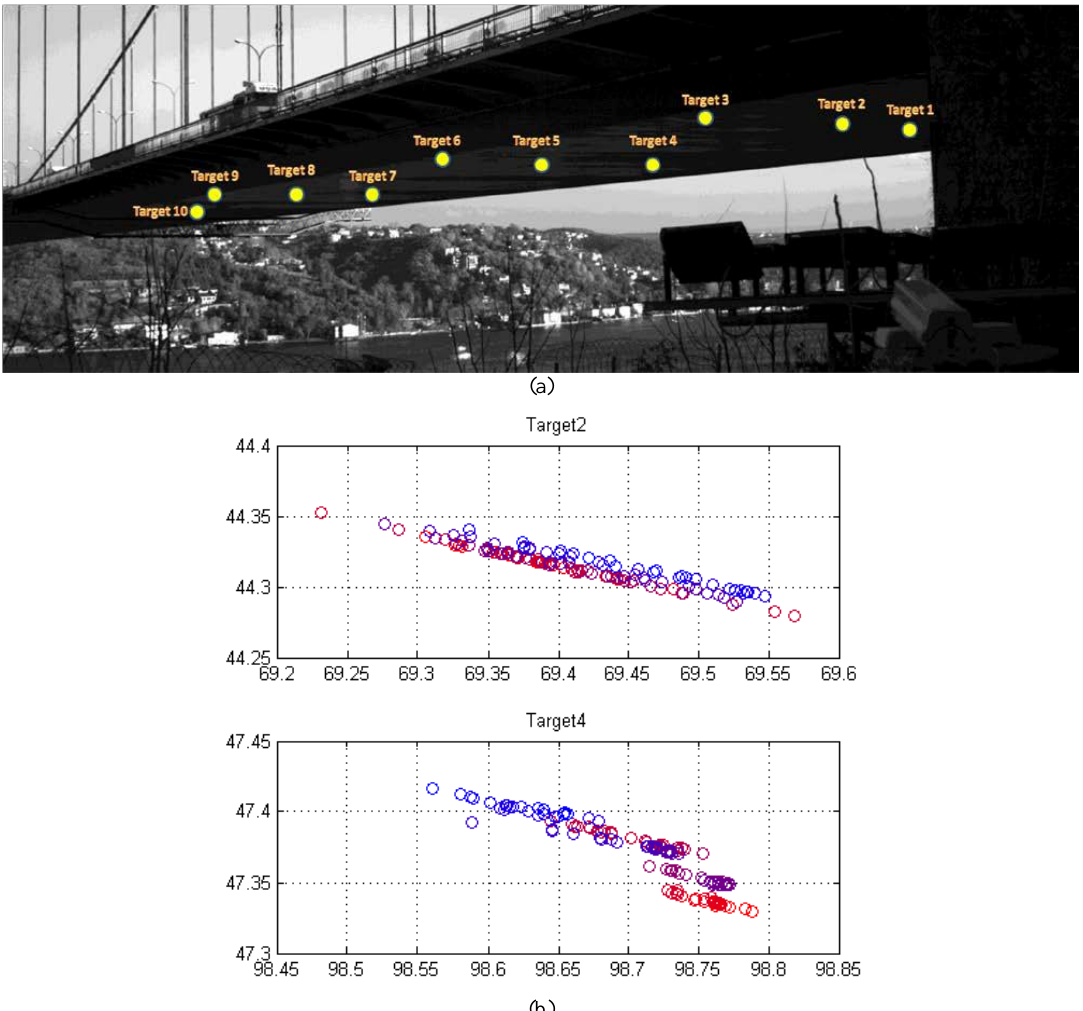
Figure 5. (a) Location of the 10 LED targets under the bridge surface. (b) The total displacement of Target 2 and